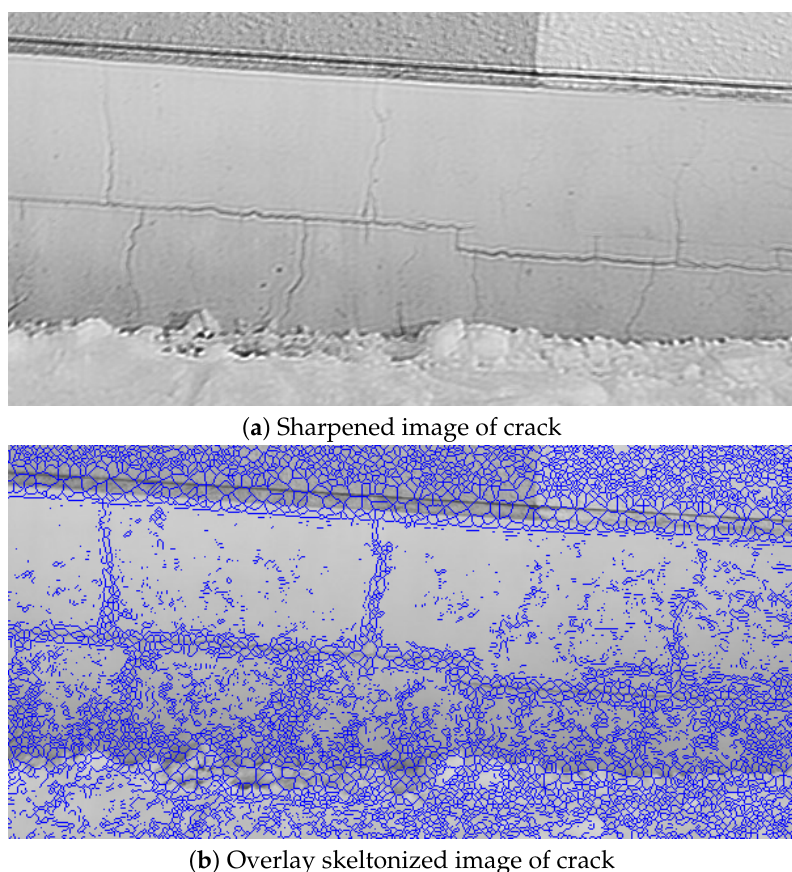
Figure 19. Sharpened image of crack deonvoluted with convoluted PSF (BS size 2, B = 5